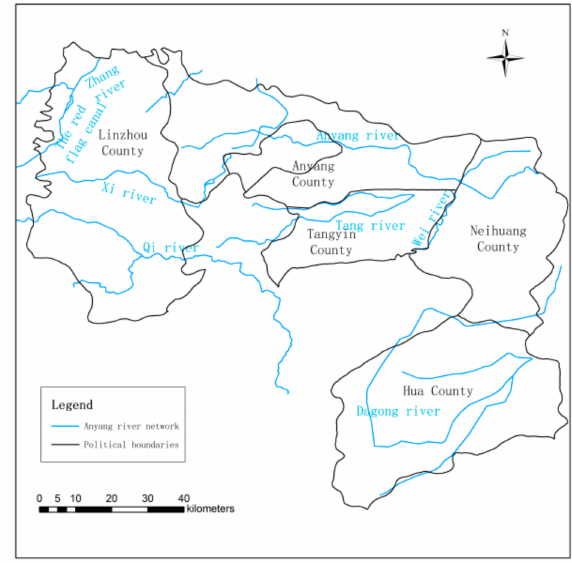
Figure 3. River network of Anyang